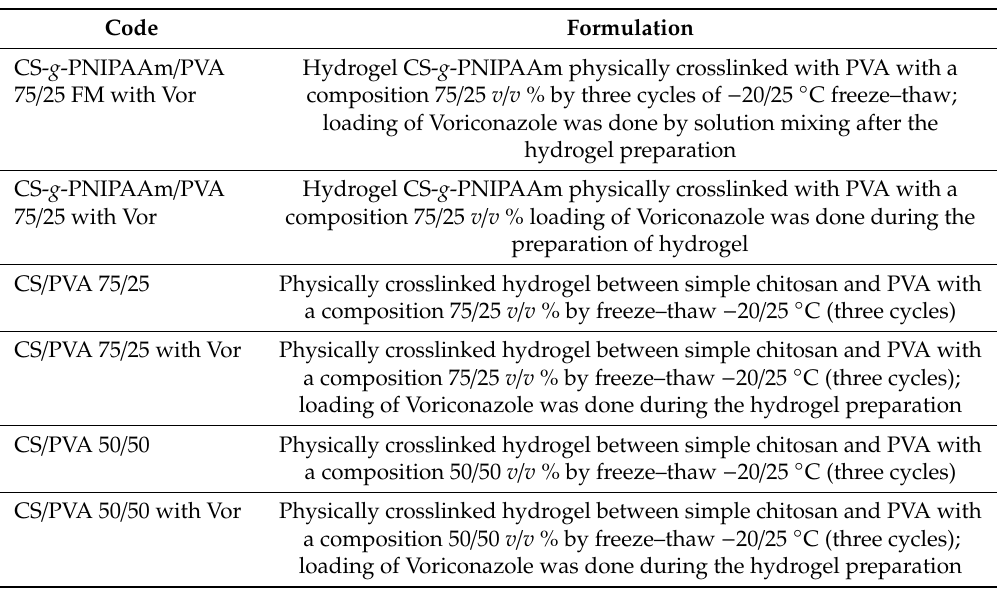
Table 1. List of formulations to be